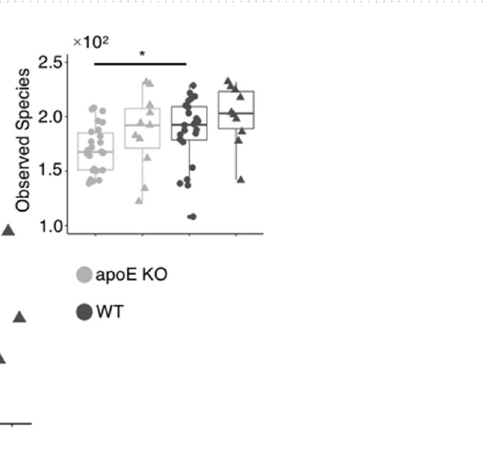
Figure 8. Multidimensional scaling plot of GM profiles ( A ) based on Sørensen-Dice dissimilarities and alpha- diversity summary based on observed species index ( B ). Analyses were based on 90,000 reads per sample on zOTUs aggregated to the species level. * difference in observed species p < 0.05. Week 10; WT n = 10, Apoe KO n = 11 and week 20; WT n = 24, Apoe KO n =